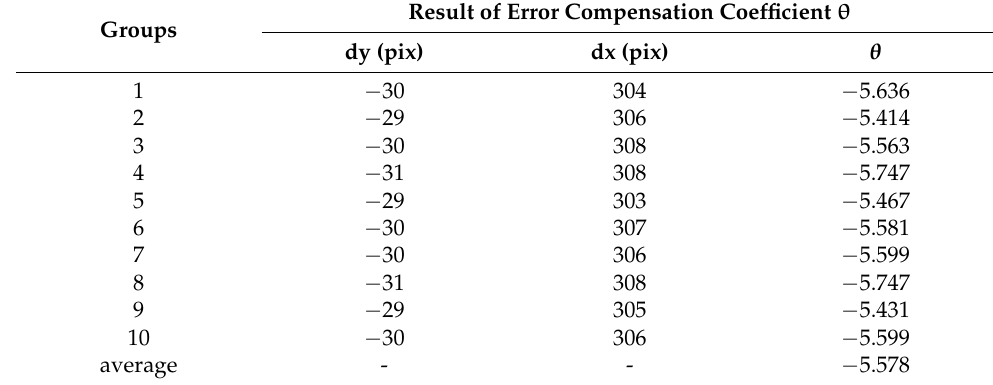
Figure 11. Effect diagram of image stitching. ( a ) X-direction, ( b ) Y-direction. Table 2. Results of error compensation coefficient 𝜃 .